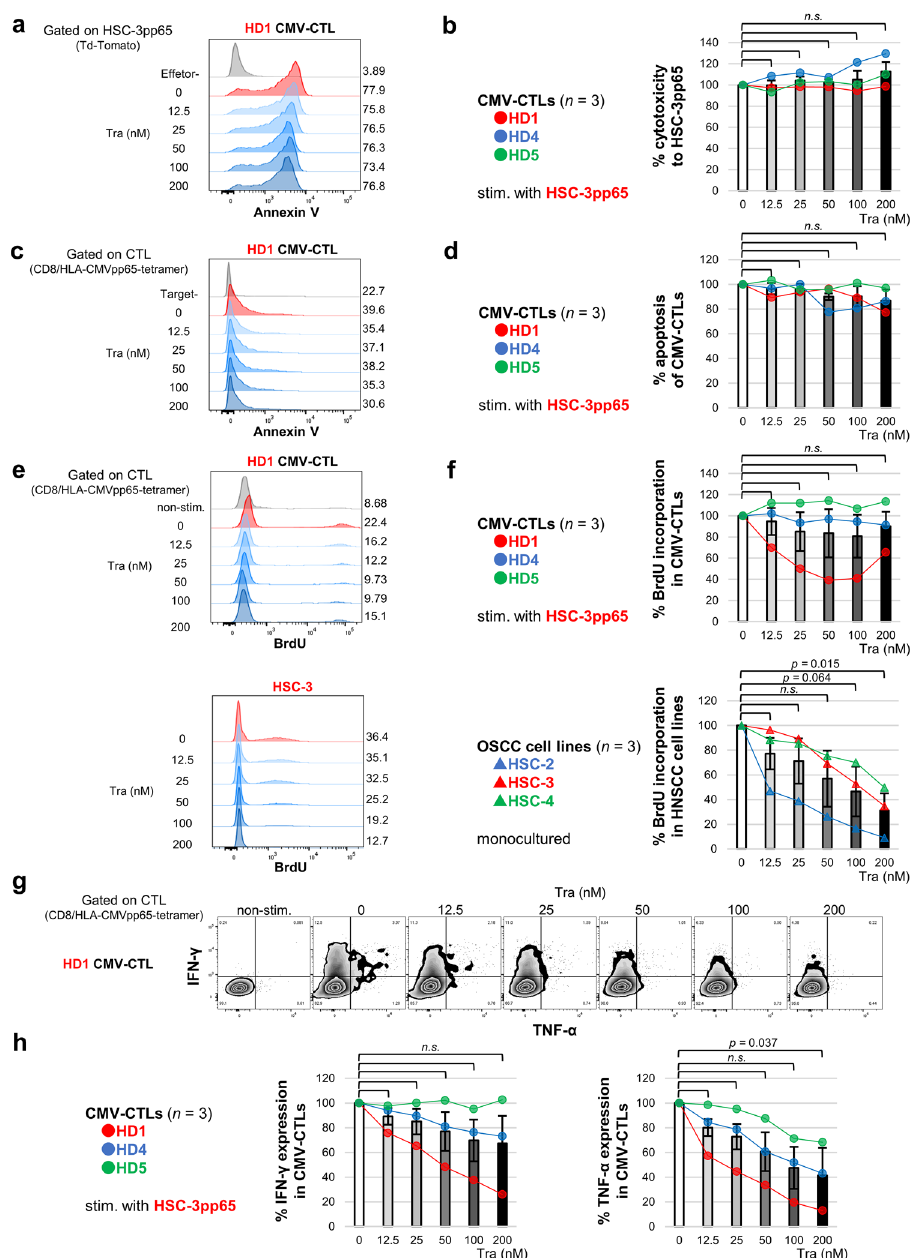
Figure 4. Trametinib inhibited cytokine expression in CTL, whereas cytotoxicity and apoptosis were unaffected and had little effect on proliferation. CMV-CTLs were co-cultured with HSC-3pp65 and performed flow cytometry. Cytotoxicity of CMV-CTLs was represented by the binding of Annexin V to HSC-3pp65 ( a,b ). Apoptosis of CMV-CTLs is represented by the binding of Annexin V to CMV-CTLs ( c,d ). The proliferation of CMV-CTLs and OSCC cell lines with a monoculture ( e,f ) was evaluated using the BrdU cell proliferation assay. Cytokine expression in CMV-CTLs was evaluated using intracellular IFN-γ and TNF-α staining ( g,h ). All figures are shown with a representative and summary of the result ( n = 3, independent donors). Error bars indicate standard errors. Statistical analysis was performed using a two-sided Dunnett’s test, and p < 0.05 was considered significant. OSCC oral squamous cell